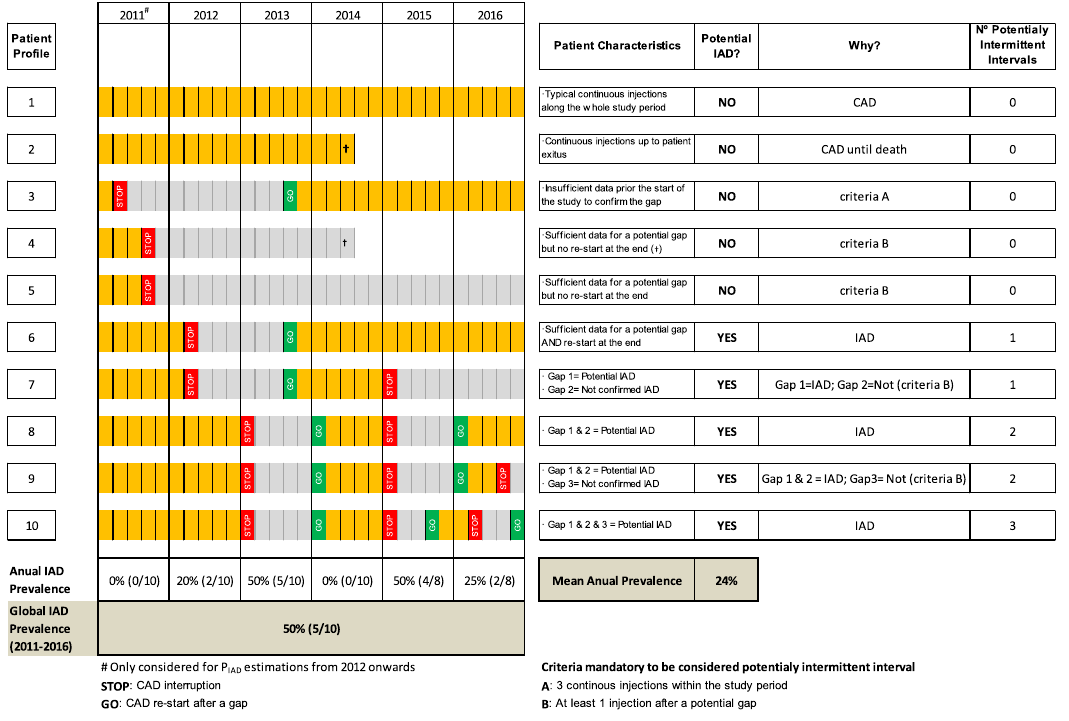
Figure 3. Simulation of 10 putative subject profiles in terms of CAD or IAD.